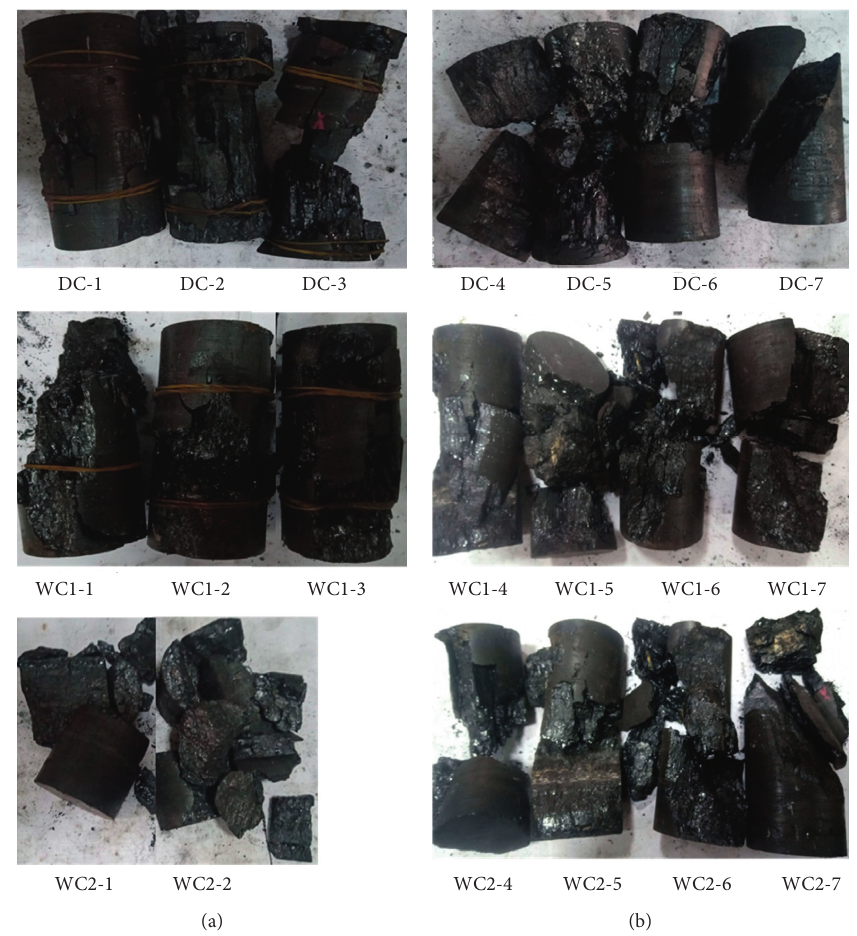
Figure 10: Failure modes of specimens: (a) the patterns under uniaxial compression and (b) the patterns under triaxial